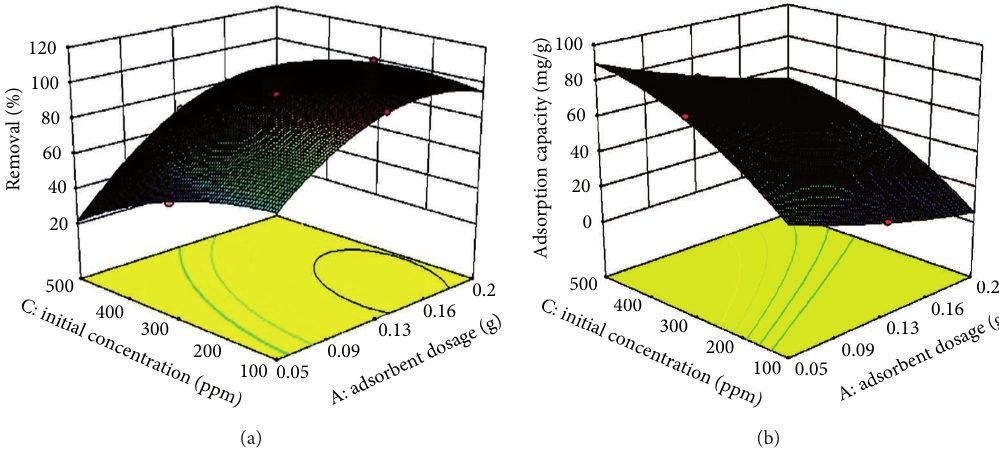
F 4: e combined effect of initial concentration and adsorbent dosage on (a) percentage removal and (b) adsorption capacity of Cr(VI) ions using